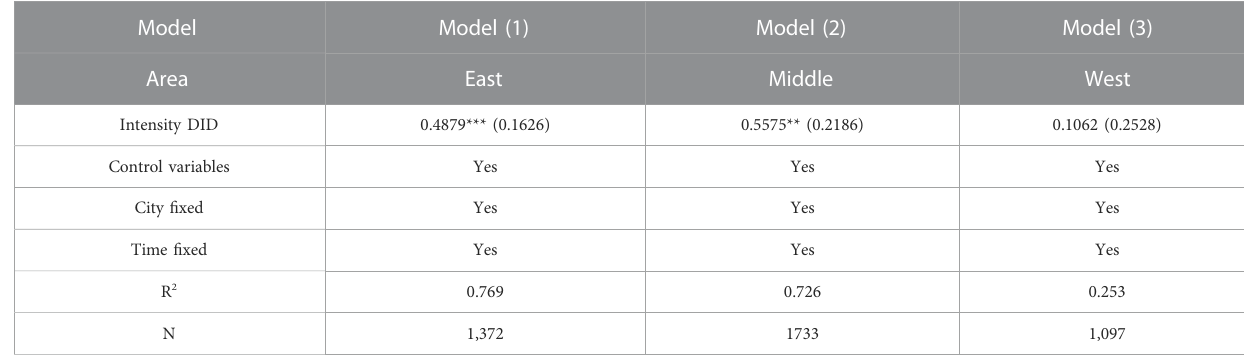
TABLE 5 Heterogeneity